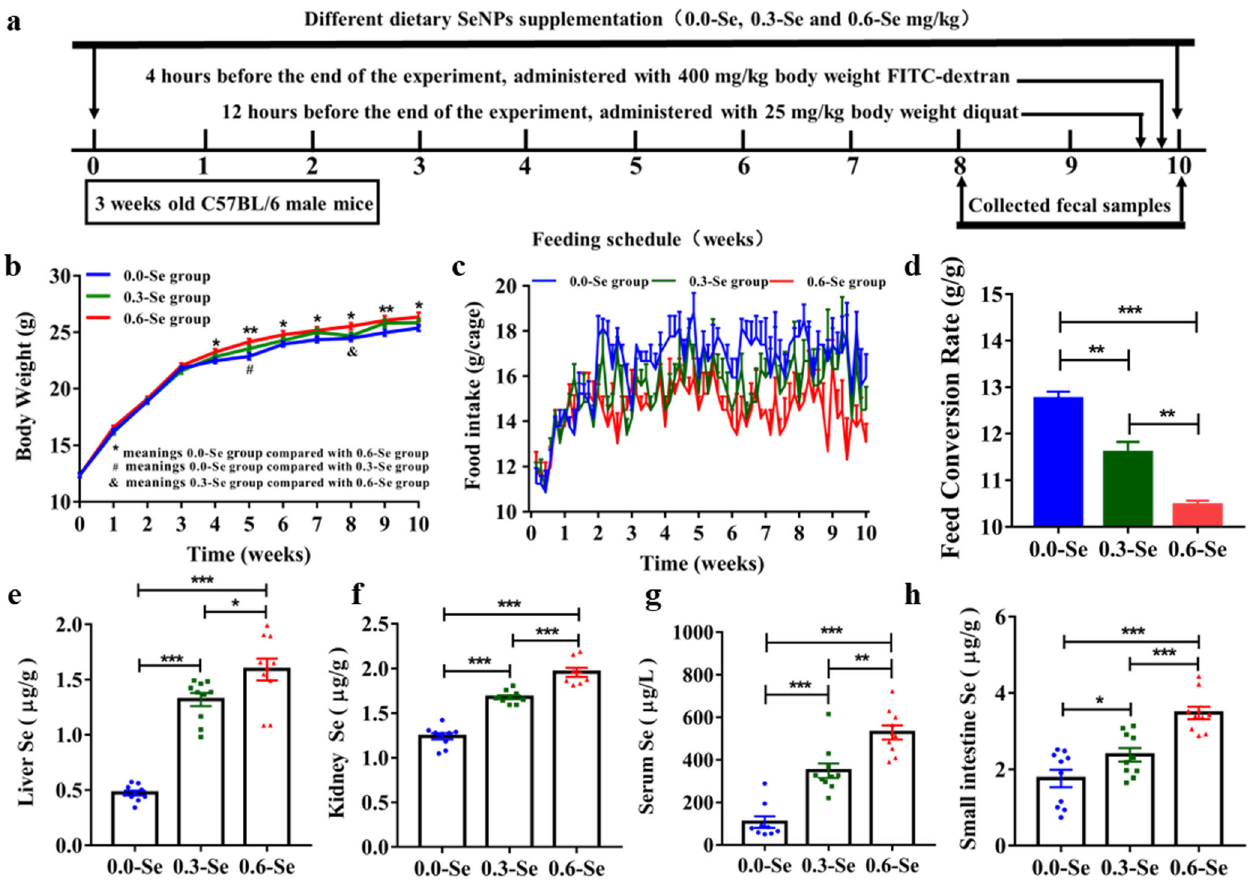
Fig. 1 Effects of different dietary SeNPs supplementation on growth performance and Se content of mice. a Schematic diagram of experiment. b Body weight and c food intake was recorded throughout the 10-week period experiment. d Feed conversion rate. e – h The Se content in the liver, kidney, serum, and small intestine, respectively, ( n = 10). Data are expressed as mean ± SEM. * P < 0.05; ** P < 0.01; *** P <